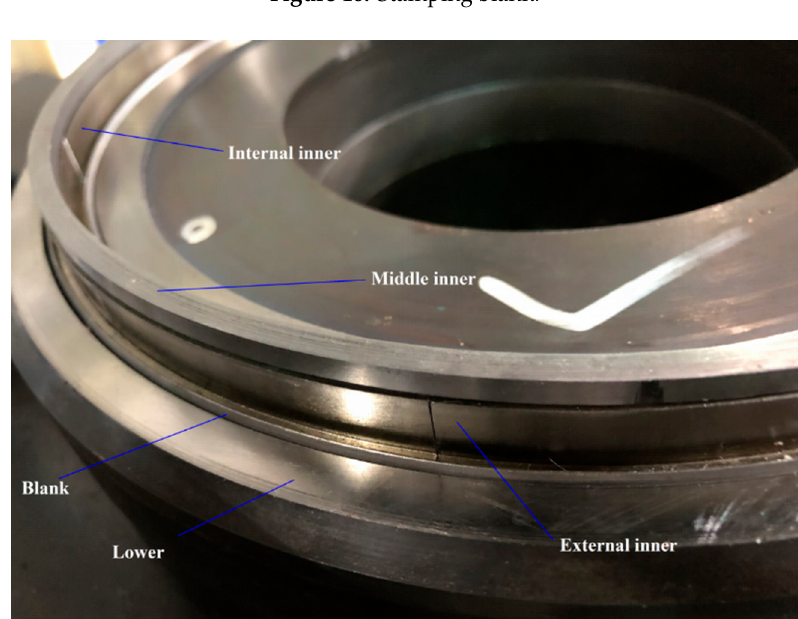
Figure 11. Blank and inner placement is complete.